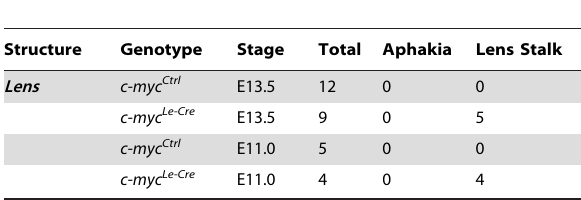
(TZ) and in the central epithelia (CE) of the c-myc Le-Cre lenses (Figure 6E). Similar analysis was performed for Prox1 expression (Figure 6F, G, H). As observed for p27 Kip1 , the total proportion of Prox1-positive cells significantly increased in c-myc-deficient lens.